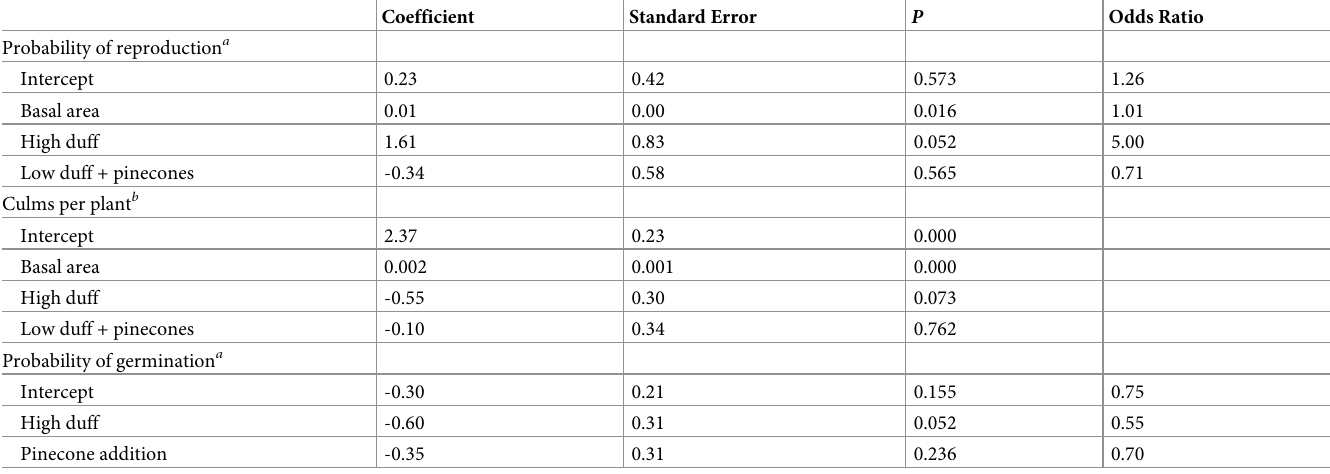
Table 1. Post-fire reproduction and